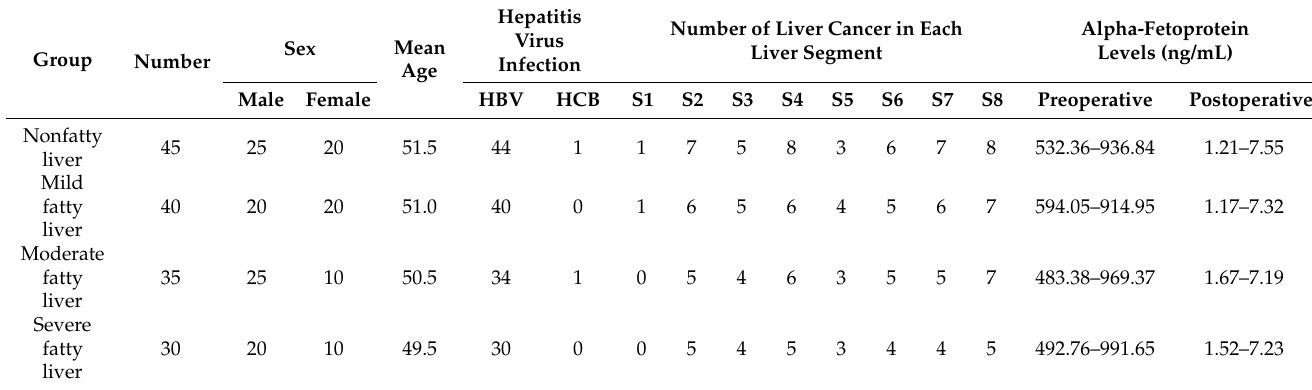
Table 1. Clinical data of all